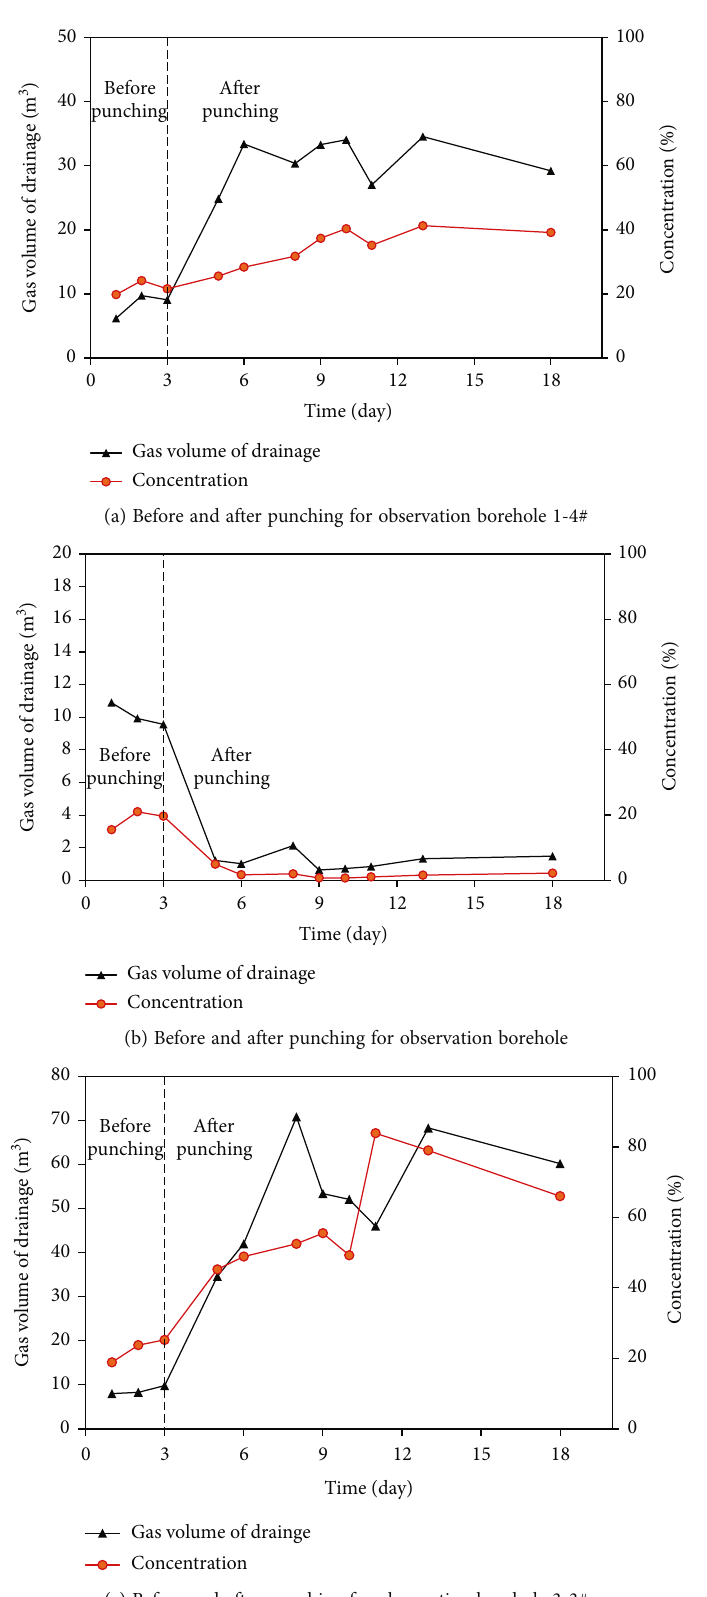
Figure 21: Gas extraction volume and concentration from boreholes used for observation in tests investigating the radius of in fl uence of a punched